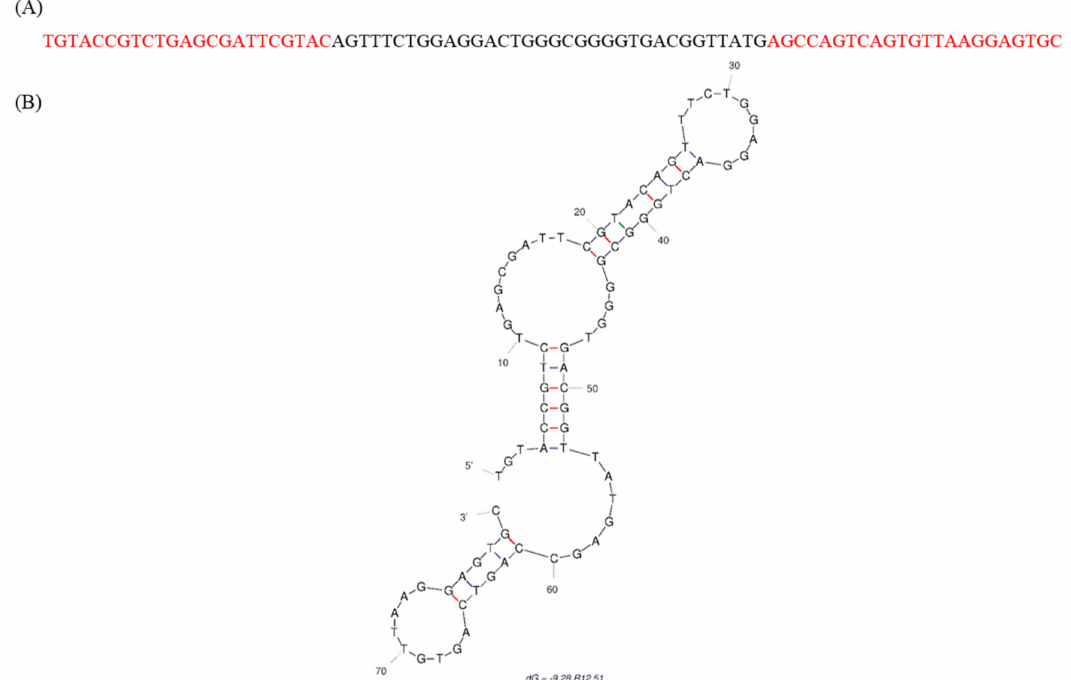
Figure 3. Secondary structure and sequence of R12.51 candidate ssDNA MRE. ( A ) ssDNA sequence of candidate fipronil MRE R12.51. The red portions indicate the constant regions for primer attachment, and the black portion indicates the variable region; ( B ) Mfold prediction of R12.51 secondary structure